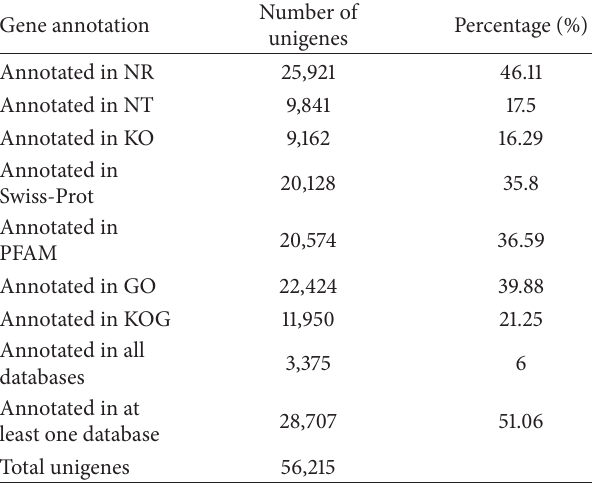
Table 1: Gene annotation by searching against public databases.